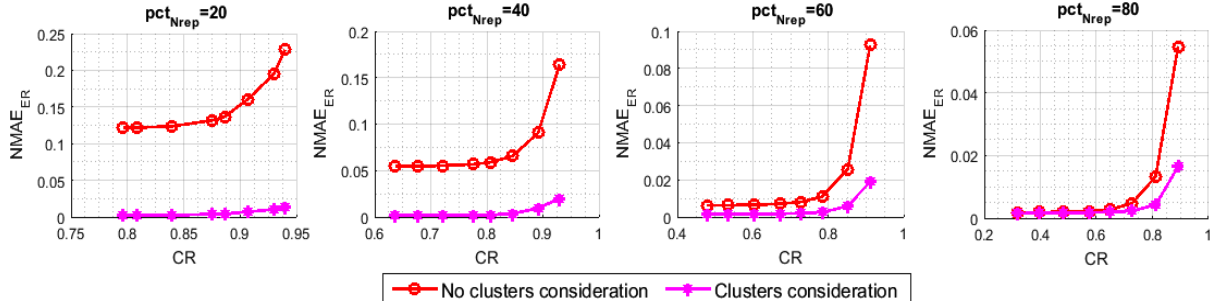
Figure 12. NMAE ER with and without clusters consideration.